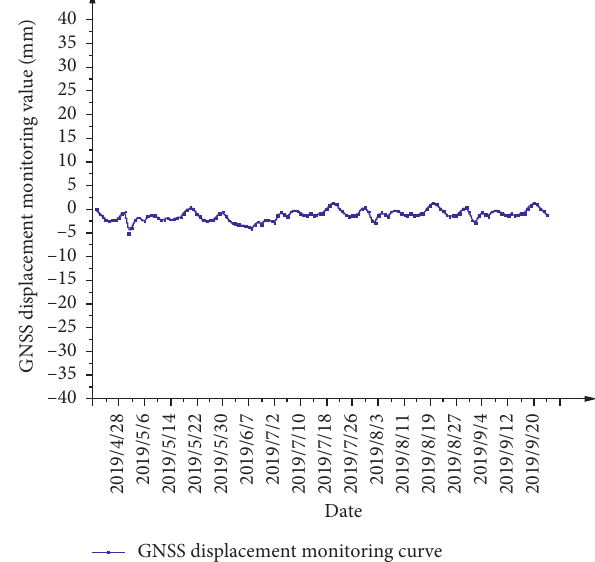
Figure 8: GNSS displacement monitoring